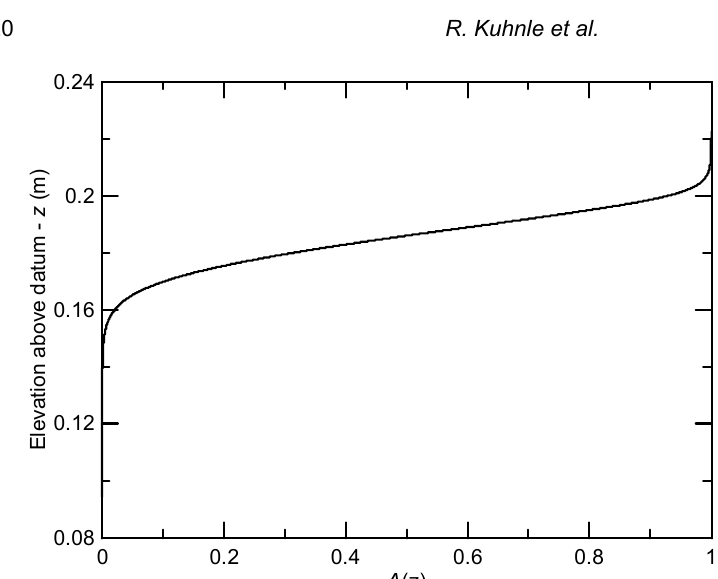
Fig. 2 Cumulative distribution function of gravel elevations (A(z)).